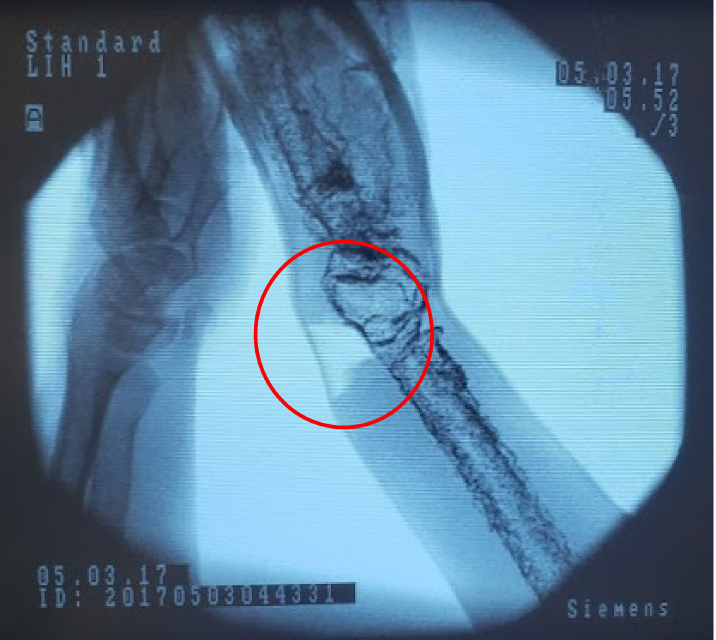
Figure 11. Fluoroscope image of our phantom showing a tear in the ballistic gelatin (circled) after manipulation of the